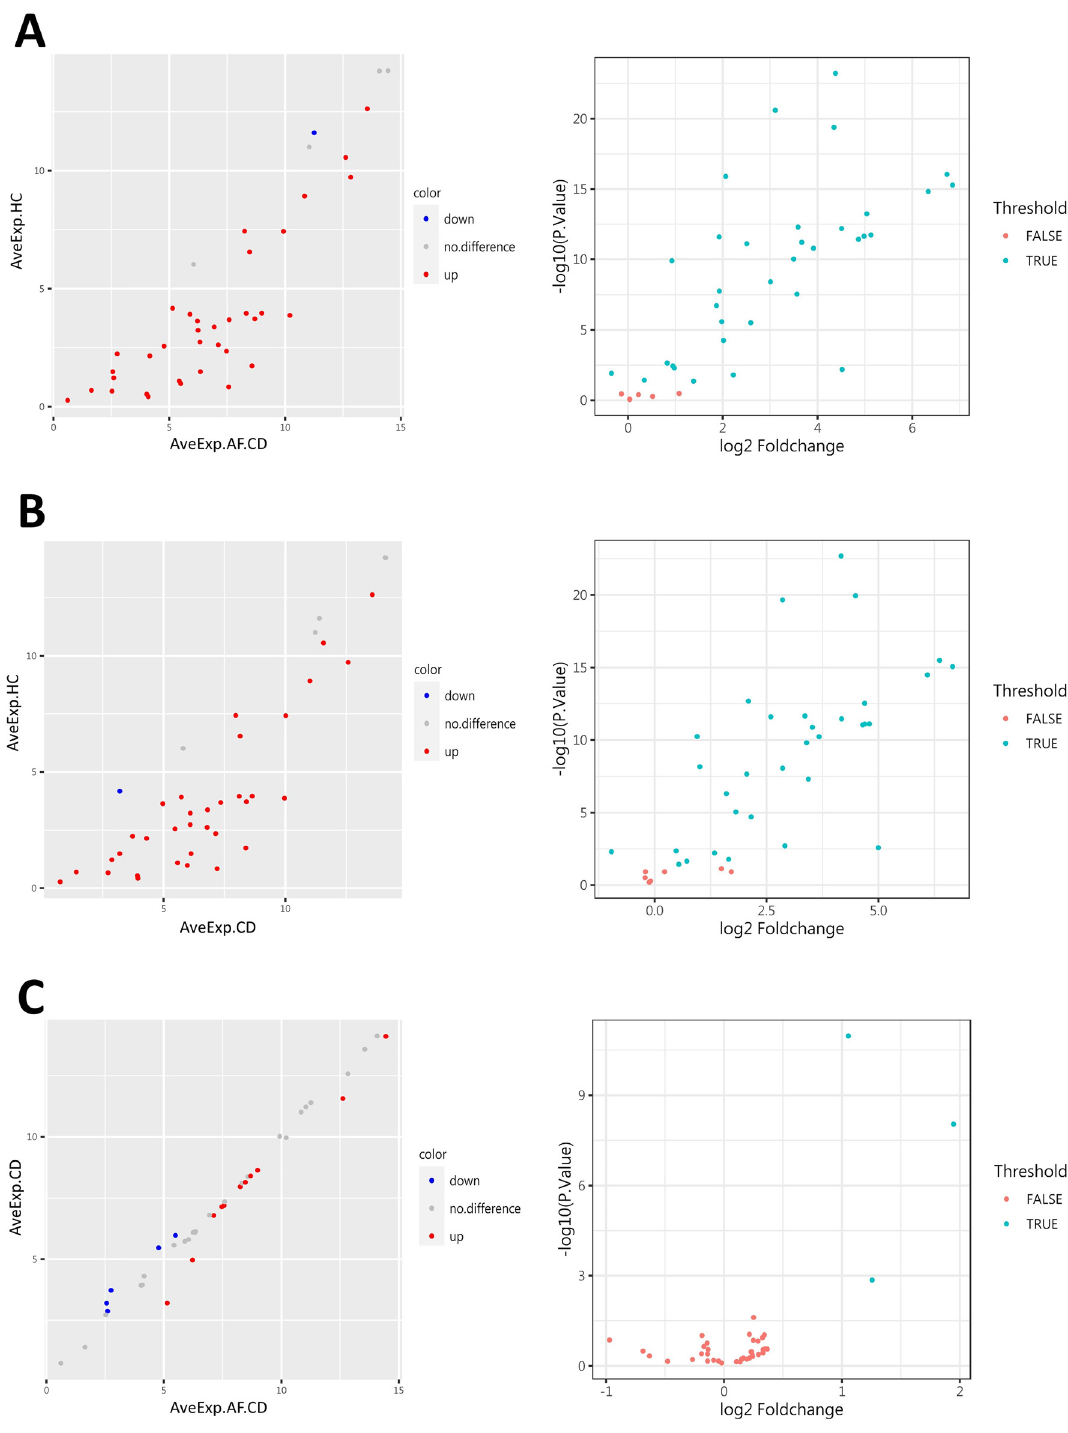
Figure 2: Analysis of differentially expressed proteins between the anal fistula with chronic diarrhea and healthy control groups (A), chronic diarrhea only and healthy control groups (B), and anal fistula with chronic diarrhea and chronic diarrhea patient groups (C). Based on the results of antibody array assay, proteins down-regulated, up-regulated or with no difference between two groups are shown as blue, red or gray spots, respectively, in left panels. The differentially expressed proteins were analyzed by fold changes between two groups shown as blue spots in the right panels. AF.CD, anal fistula with chronic diarrhea; CD, chronic diarrhea; HC, healthy